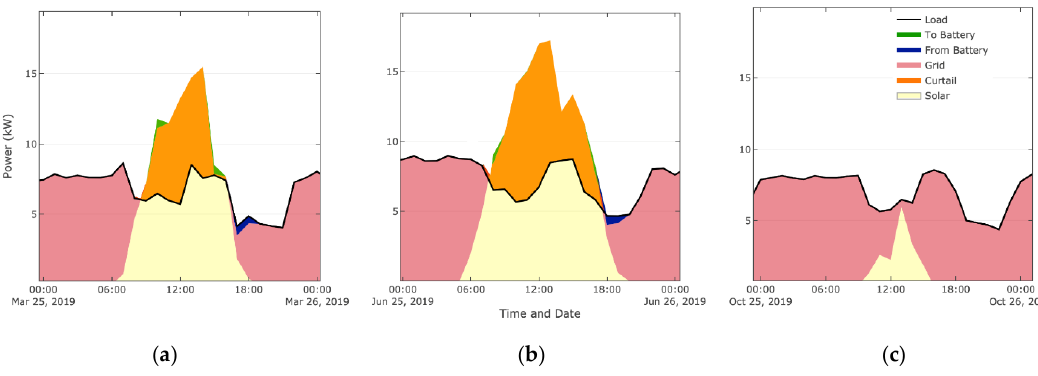
Figure 2. Modeled electric profiles resulting from operating the optimized solar and storage system with the collected container farm load data for three representative seasonal periods: ( a ) spring, ( b ) summer, and ( c ) fall. In spring, a small amount of excess solar was used to charge the battery at the beginning and end of the solar day with even smaller amounts of charging necessary during the summer, given that more solar energy is available from day to day. Any excess solar generation, beyond the load and charging to the battery, was curtailed. When the battery had energy in storage, it was fully discharged in the early evening hours. In late fall and winter, solar energy output was less than the container farm load.